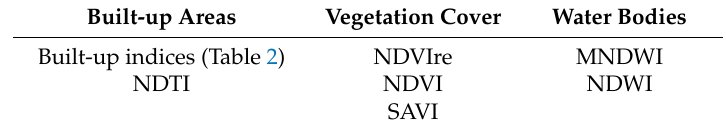
Table 1. Spectral indices used in this research categorized according to three main LCU classes.